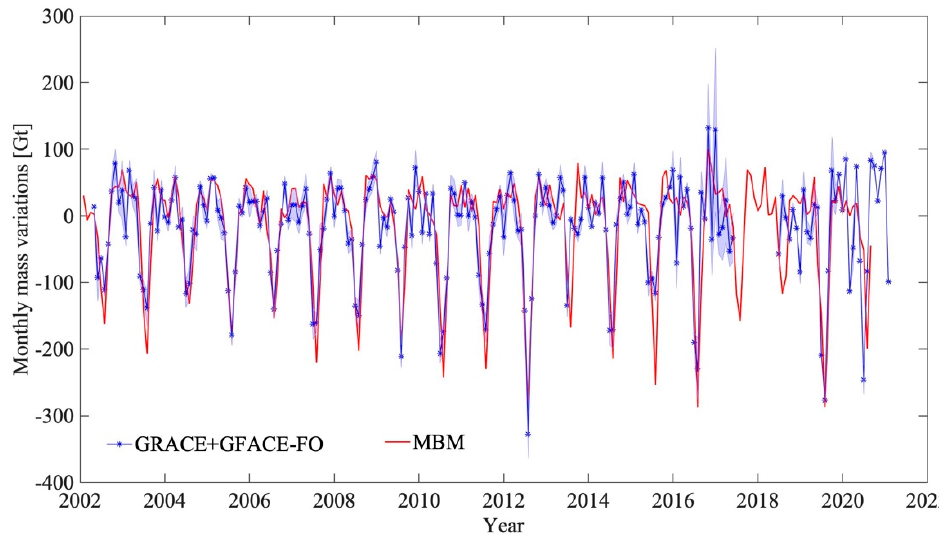
Figure 1. Monthly non-cumulative mass change time series of the GrIS derived separately from GRACE/GRACE-FO gravimetry and the MBM during 2002–2020.